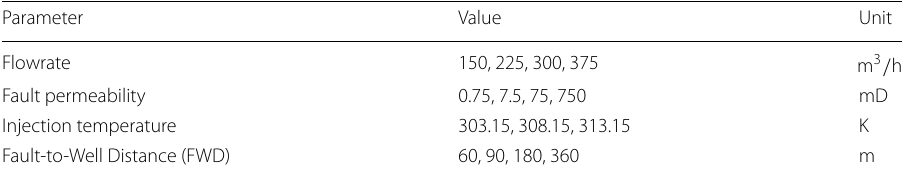
Table 2 Varying parameters of the reservoir model. The lowest fault permeability of 0.75 mD is referred to as a sealing fault and the highest fault permeability of 750 mD as transmissive fault in